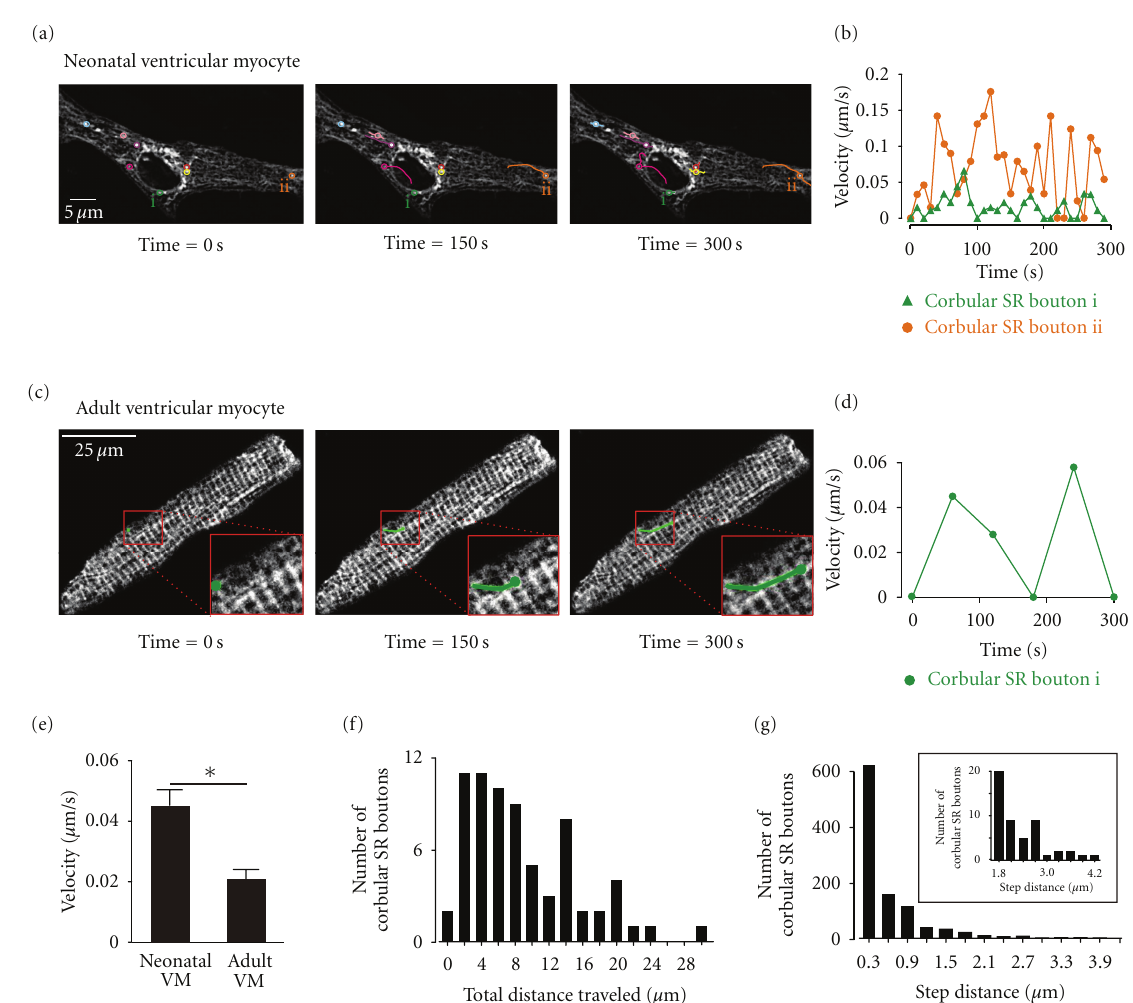
Figure 3: Motile corbular SR boutons in neonatal and adult ventricular myocytes. (a) Time-lapse confocal images of a neonatal ventricular myocytes expressing tRFP-SR. Images shown were obtained 0, 150, and 300 seconds after the initiation of the experiment. Motile corbular SR boutons are labeled with colored circles. (b) Plot of the velocity of corbular SR boutons i and ii as a function of time. (c) Time-course of corbular SR bouton motility in a representative adult ventricular myocyte expressing tRFP-SR. The insets in the lower right corner of each image show an expansion of the region in the cell marked by the red box. (d) Plot of velocity of this corbular SR bouton as a function of time. (e) Bar plot of the mean velocity of corbular SR boutons in neonatal and adult ventricular myocytes ( ∗ P < 0 . 05). (f) Histogram of the total distance traveled over a period of 300 seconds of 79 corbular SR boutons in adult and neonatal ventricular myocytes. (g) Histogram of the step distance traveled by corbular SR boutons. The inset shows an expanded view of the region of the histogram from 1.8 to 4.2 μ m.